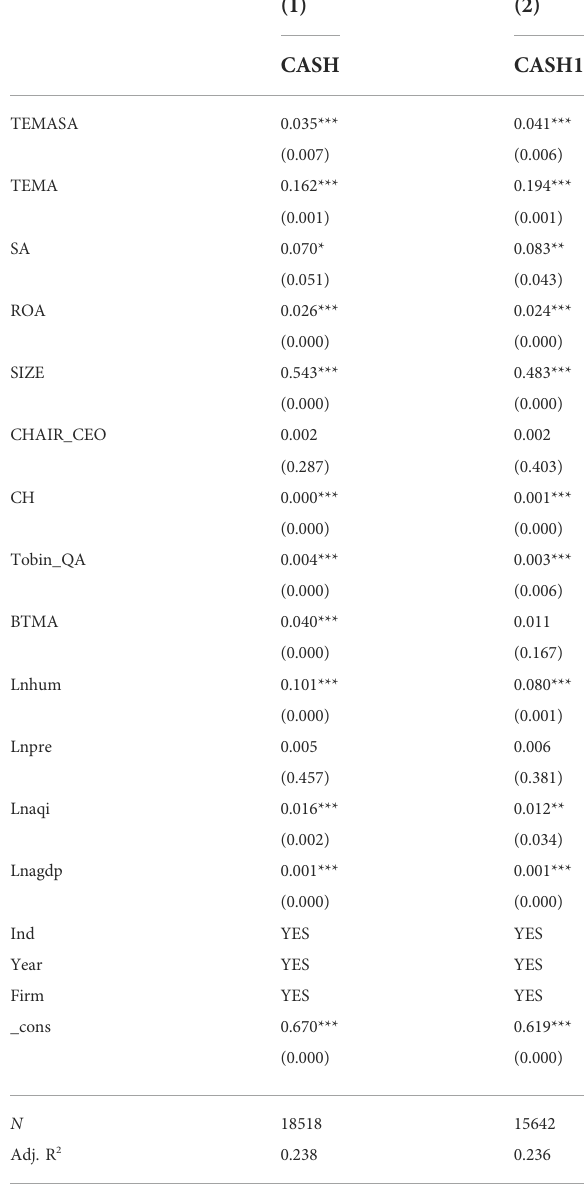
TABLE 11 Climate change, fi nancing constraints, and corporate cash